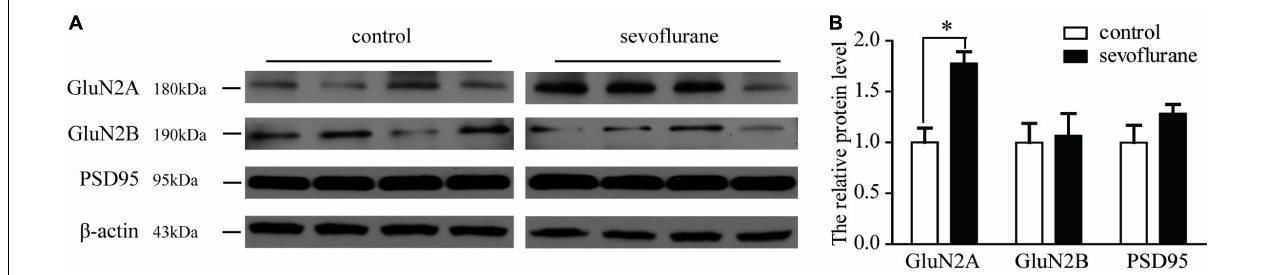
FIGURE 4 | (A) Western blotting of GluN2A, GluN2B, and PSD95 in mice of following group: control, sevoflurane. (B) Quantification of GluN2A, GluN2B, and PSD95 in mice of the following groups: control and sevoflurane-treated. Sevoflurane increased the GluN2A expression. Seven-day-old pups were exposed to 3% sevoflurane for 4 h and then allowed to grow up to 2 months. They were then subjected to the open field and water maze test. Then, their hippocampus was immediately removed for Western blot analysis. GluN2A expression was significantly increased by sevoflurane exposure. Data are presented as mean ± SEM ( n = 4); ∗ P < 0.05.